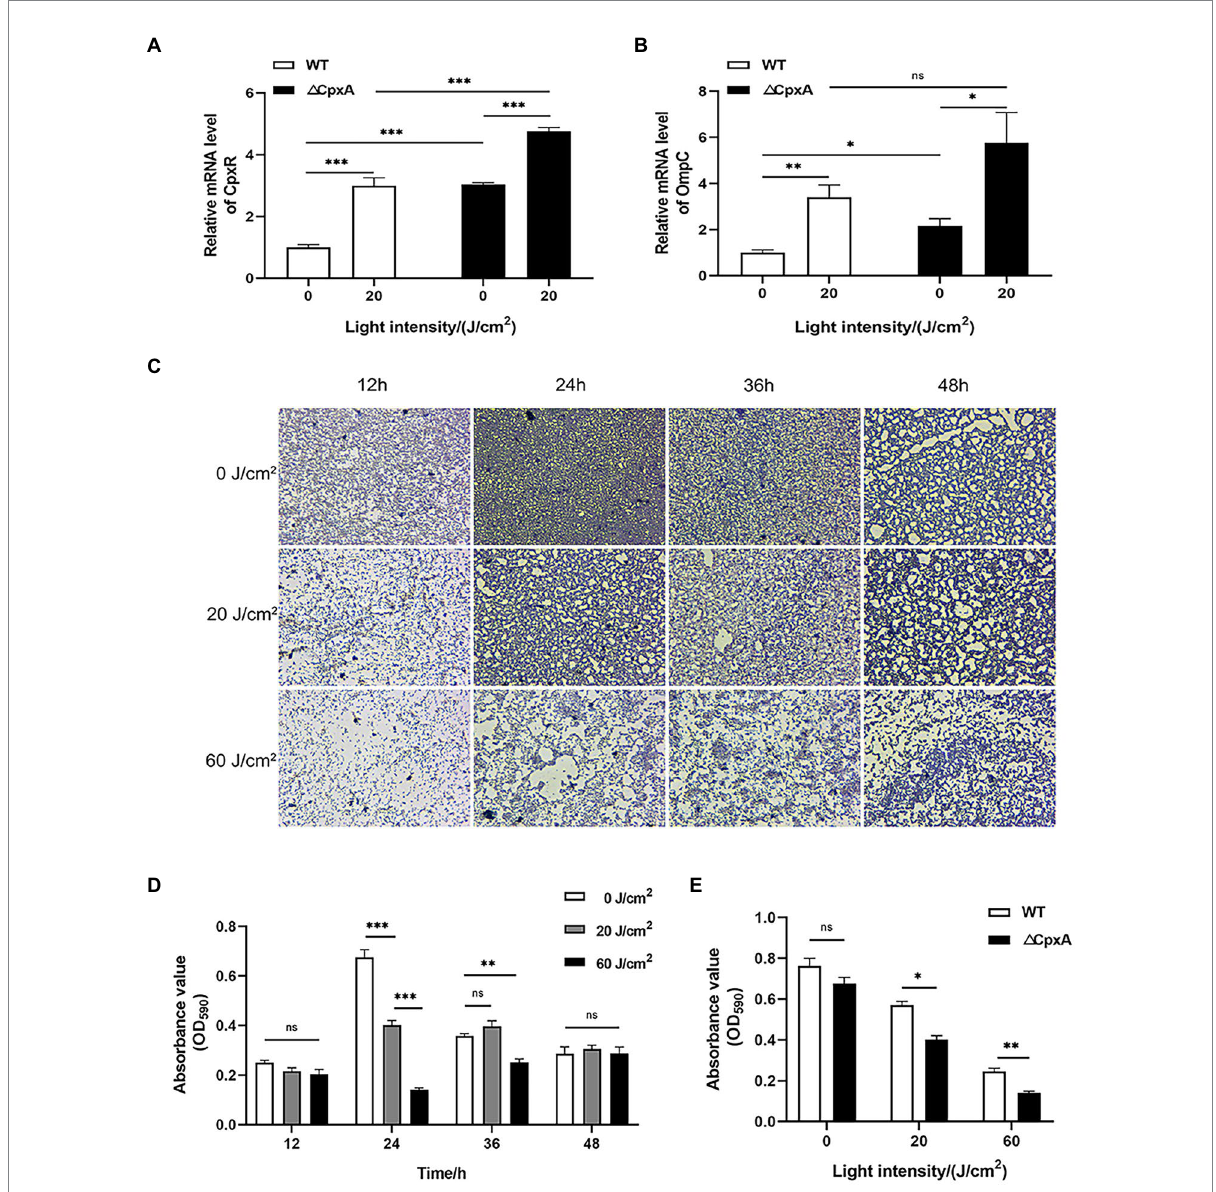
FIGURE 7 Effect of aPDI on the biofilm formed by Δ CpxA. qPCR was first performed to examine mRNA levels of CpxR (A) and OmpC (B) , in response to CpxA deletion as well as aPDI exposure. Δ CpxA strain was treated with HB activated by 460-nm LED illumination (20 or 60 J/cm 2 ) before crystal violet staining. OD 590nm measurements of CV-stained biofilms grown on 96-well plates (C) were performed at the various stages of biofilm formation (12 h, 24 h, 36 h, and 48 h) (D) . The representative microscopy images were shown to indicate the biofilm status under aPDI-induced pressure. In addition, the comparisons between wildtype and mutant were performed with respect to their biofilm status at a growth of 24 h (E) . Values are the mean ± SEM (standard error of mean) from 4~6 replicates. * p < 0.05, ** p < 0.01, *** p < 0.001, ns, p >